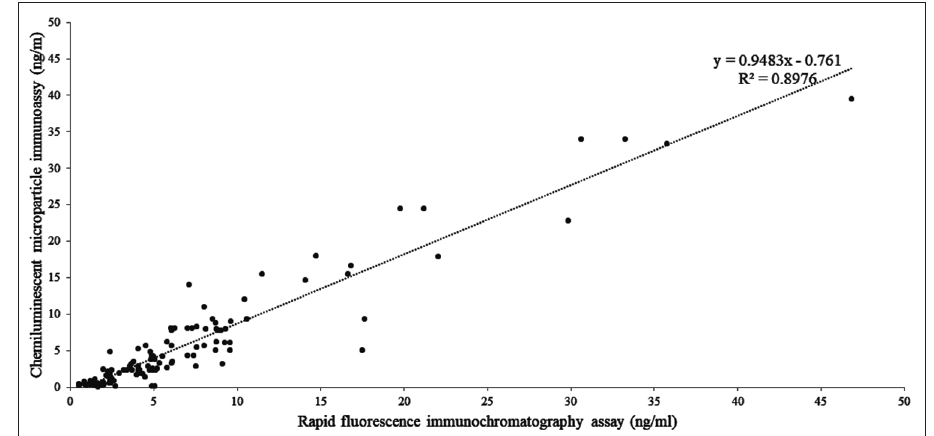
Figure-1: Correlation graph of progesterone measurement between rapid fluorescence immunochromatography assays compared with chemiluminescent microparticle immunoassay. Table-1: Concentrations of progesterone measured with RFICA and CMIA and critical times during estrus in bitches. Stage of Minimum 25 th percentile Median 75 th percentile Maximum estrous cycle Anestrus, proestrus, and pre-LH surge (below 2.00 ng/mL) CMIA